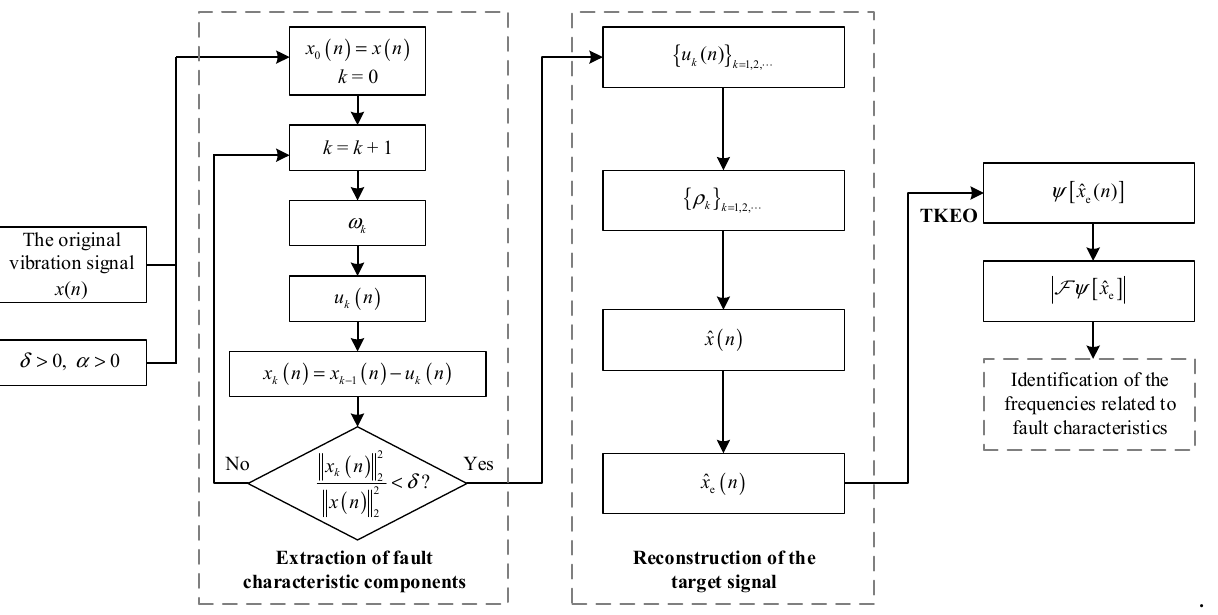
Figure 3. Flow chart of improved TKEO.